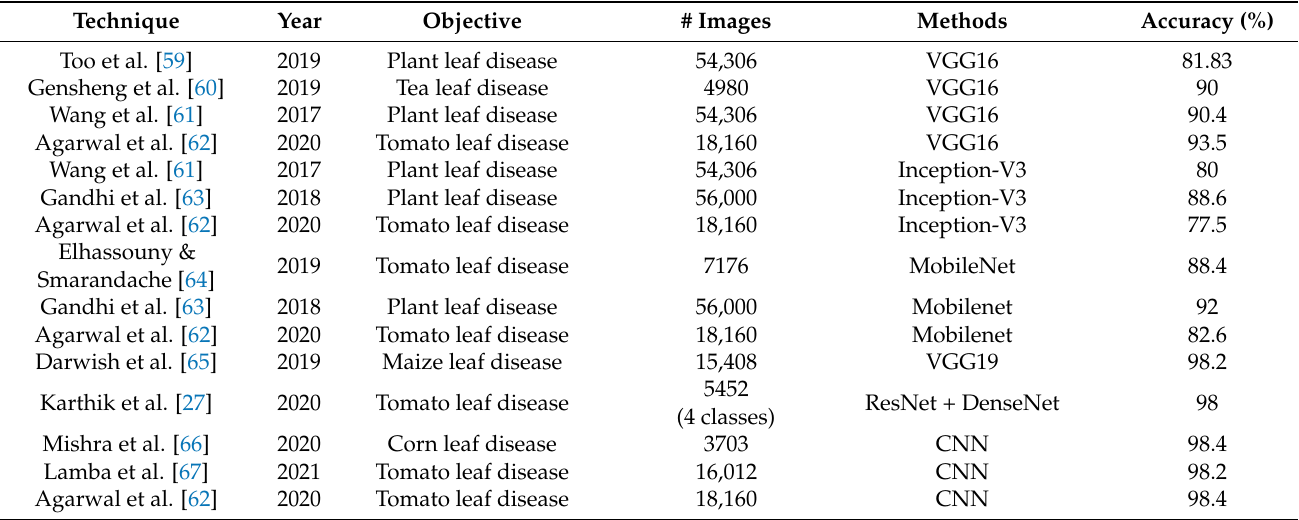
Table 11. Comparison of the proposed technique with the existing prevalent approaches on the tomato leaf